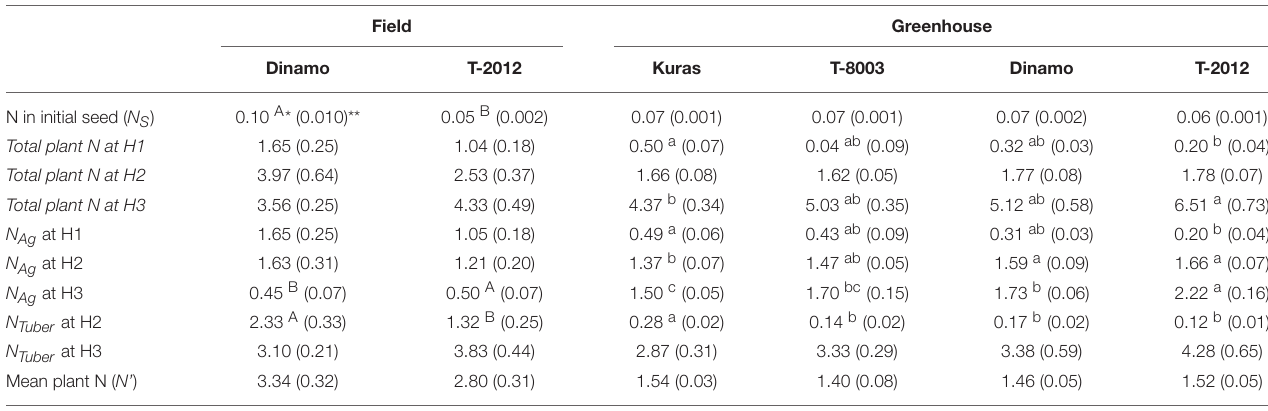
TABLE 3 | Mean of plant N in the initial seed, total plant N at tuber initiation stage (H1), flowering stage (H2) and final harvest (H3), mean N in the above-ground biomass ( N